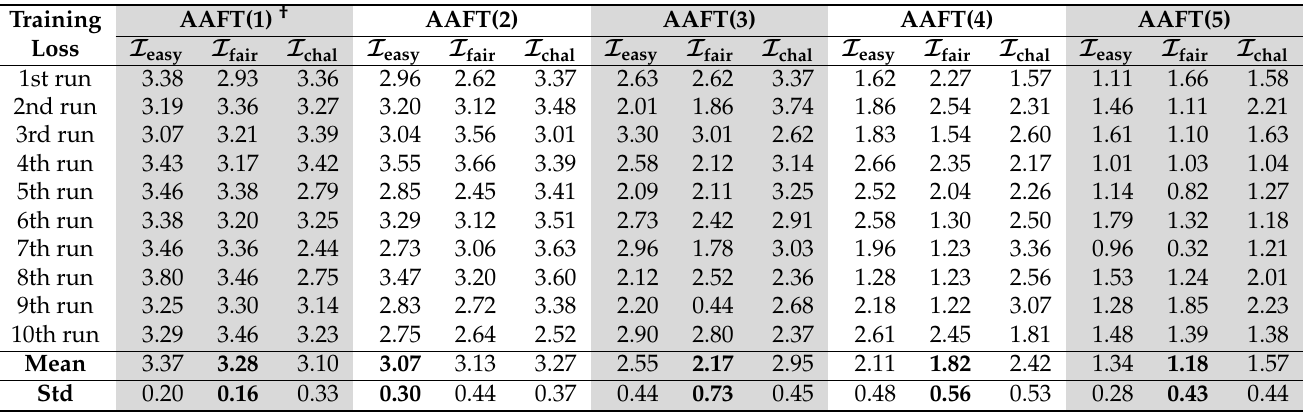
Table 1. The mean and standard deviation of training loss.